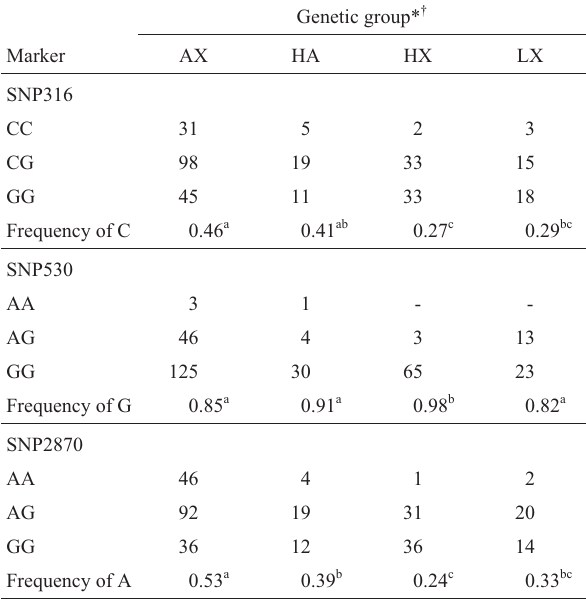
Table 2 - Genotype and allele frequencies of the CAPN1 gene SNP316 and SNP530 markers and the CAST gene SNP2870 marker. Genetic group* †